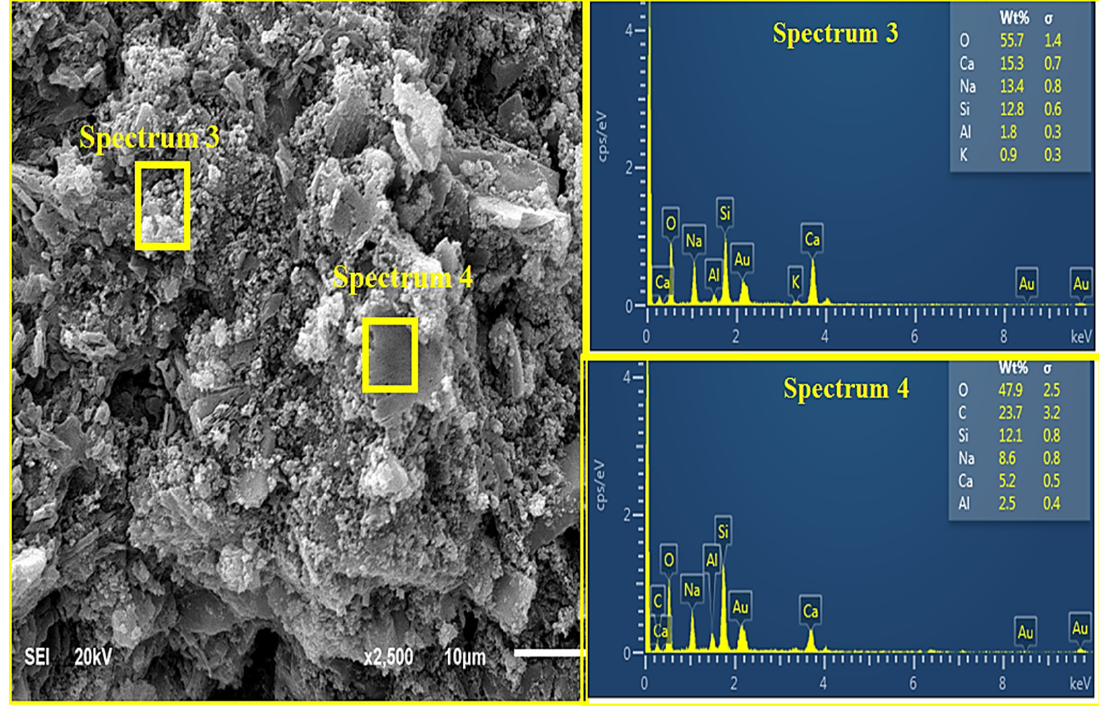
Figure 10. SEM + EDX result of AANL activated using combined NaSiO 3 and 10 M NaOH.